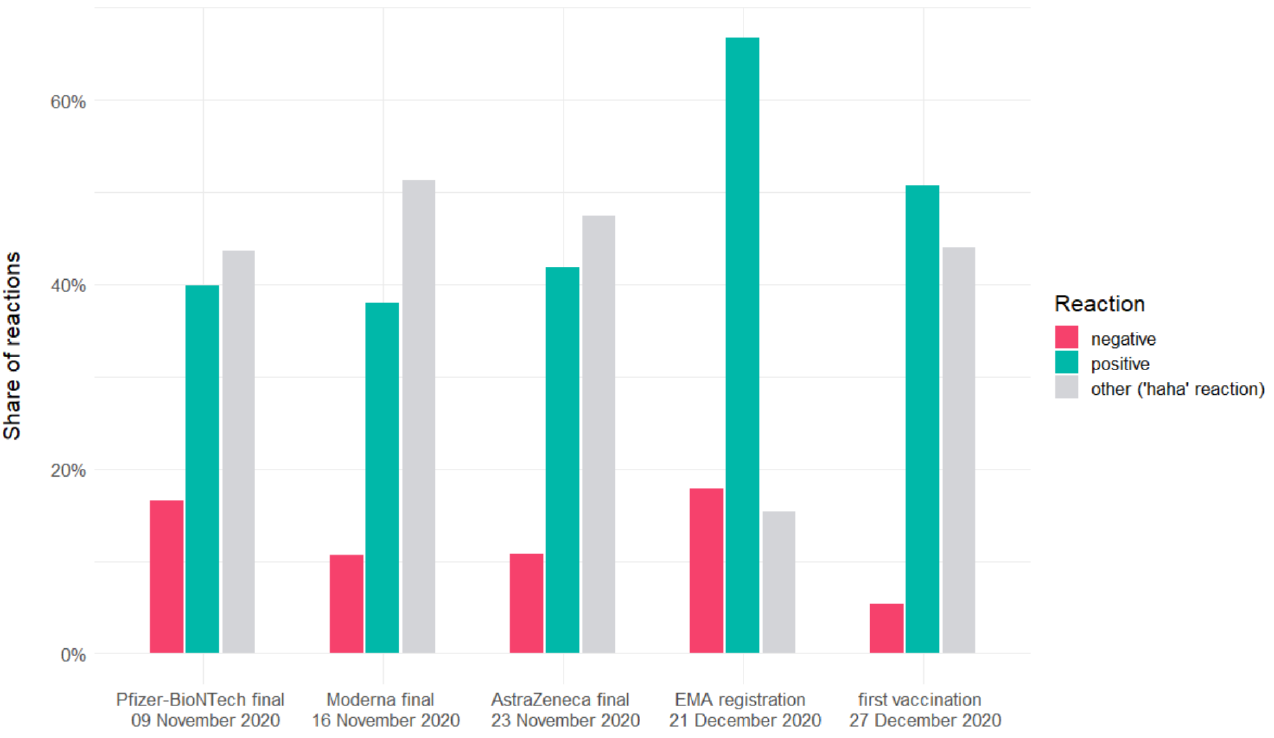
Figure 2. Reactions connected to the